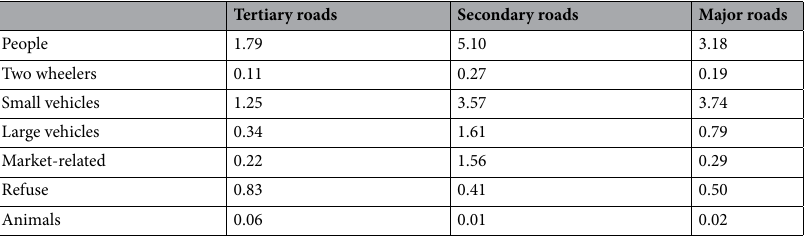
Table 1. Object counts by the type of road on which sites were located. Mean counts per image for each object category, shown in Fig. 5, were averaged across sites located on the category of road at which the site was located. Road type from OpenStreetMap (2019).